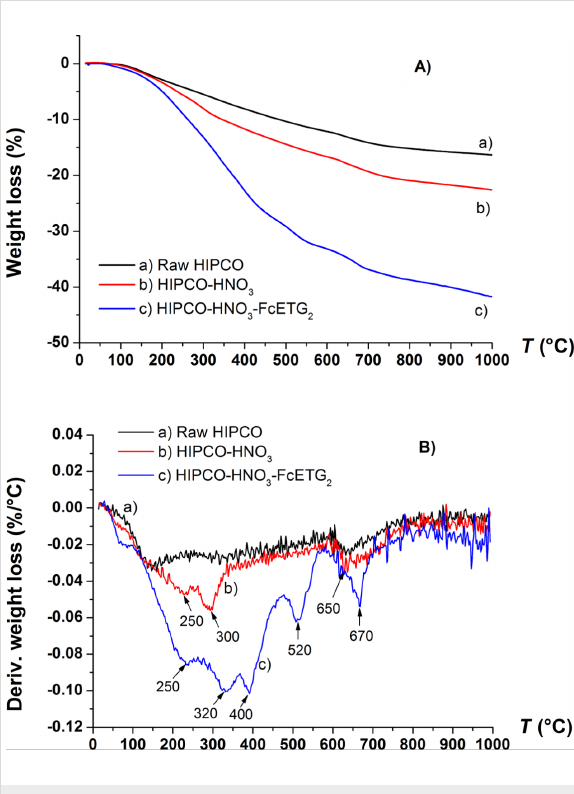
Figure 6: A) TGA curves obtained under He for three samples. B) De- rivative curve of the weight loss for the same three samples. Arrows in- dicate the main peaks in temperature associated with departure of some chemical groups attached to SWCNT sidewalls.